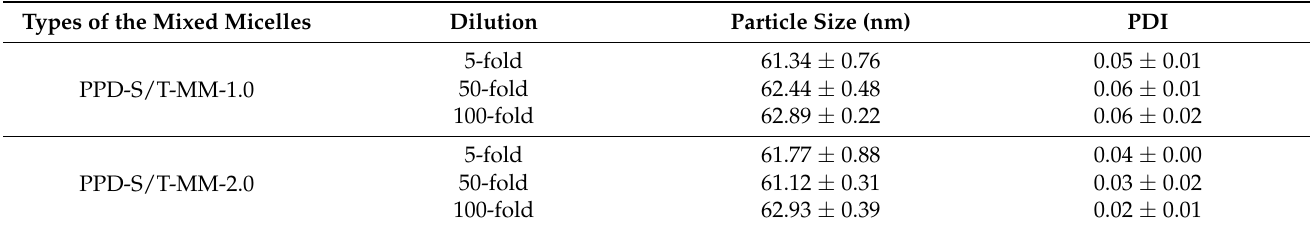
Table 4. Particle size and PDI of PPD-S/T-MM in dilution stability study (Mean ± SD, n = 3). Types of the Mixed Micelles